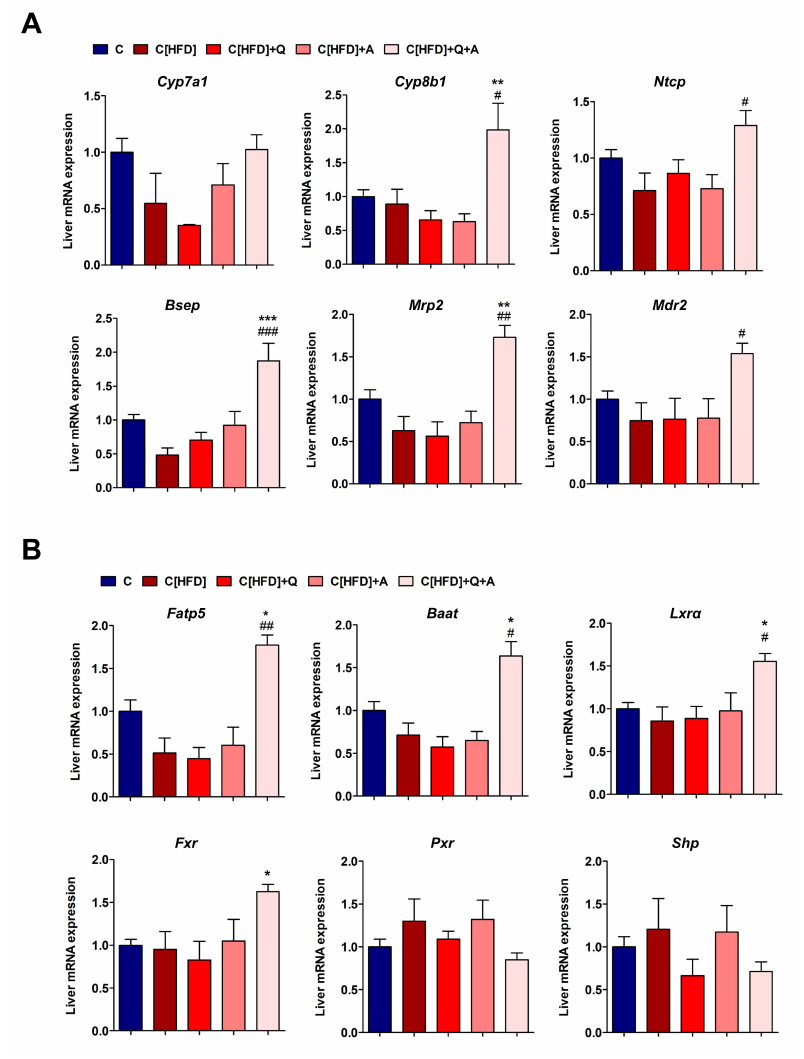
Figure 7. Effect of diet, quercetin and A. muciniphila supplementation on the expression of BA and lipid metabolism genes in the liver of juvenile NAFLD rats. ( A ) Liver mRNA expression of main BA synthesis genes ( Cyp7a1 and Cyp8b1 ), and of major basolateral BA uptake ( Ntcp ) and canalicular bile efflux ( Bsep , Mrp2 and Mdr2 ) transporters. ( B ) Expression of the BA-CoA ligase ( Fatp5 ), the BA- CoA:amino acid N-acyltransferase ( Baat ), and of the BA-related nuclear receptors Fxr , Pxr , Lxr α , and Shp . Expression of mRNA is normalized to the mean values of C rats. Data represent mean ± SEM. * p < 0.05, ** p < 0.01, *** p < 0.001, vs. C; # p < 0.05, ## p < 0.01, ### p < 0.001, vs. C[HFD] by one-way ANOVA followed by Tukey’s multiple comparison